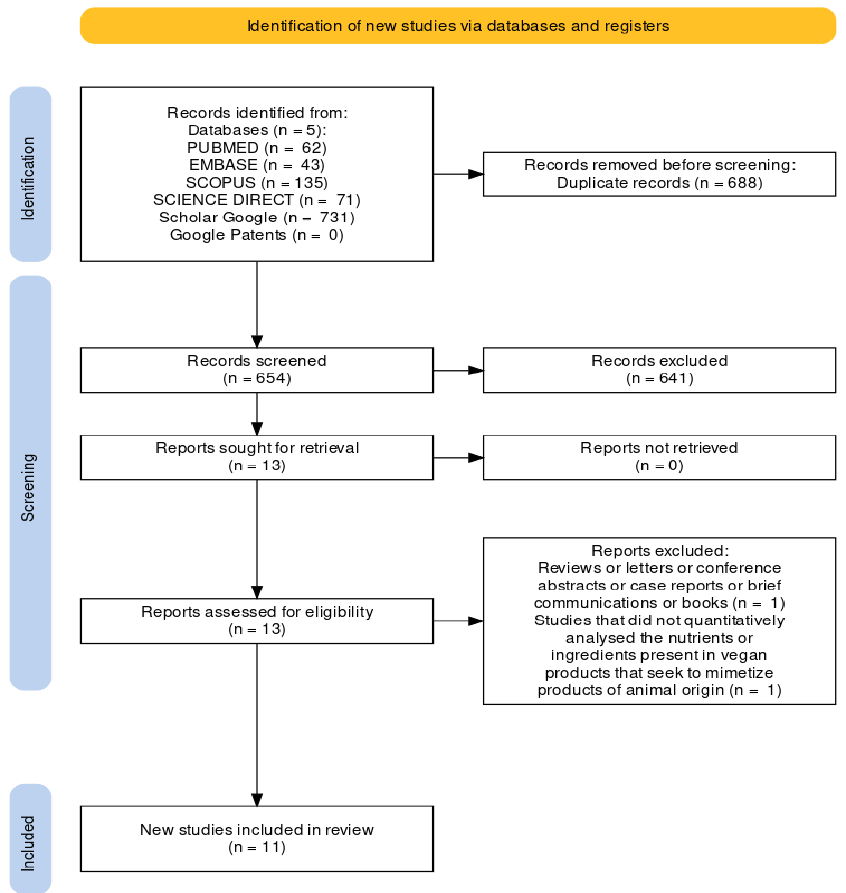
Figure 1. Flow diagram of the literature search and selection phases adapted from PRISMA guide- lines [13].